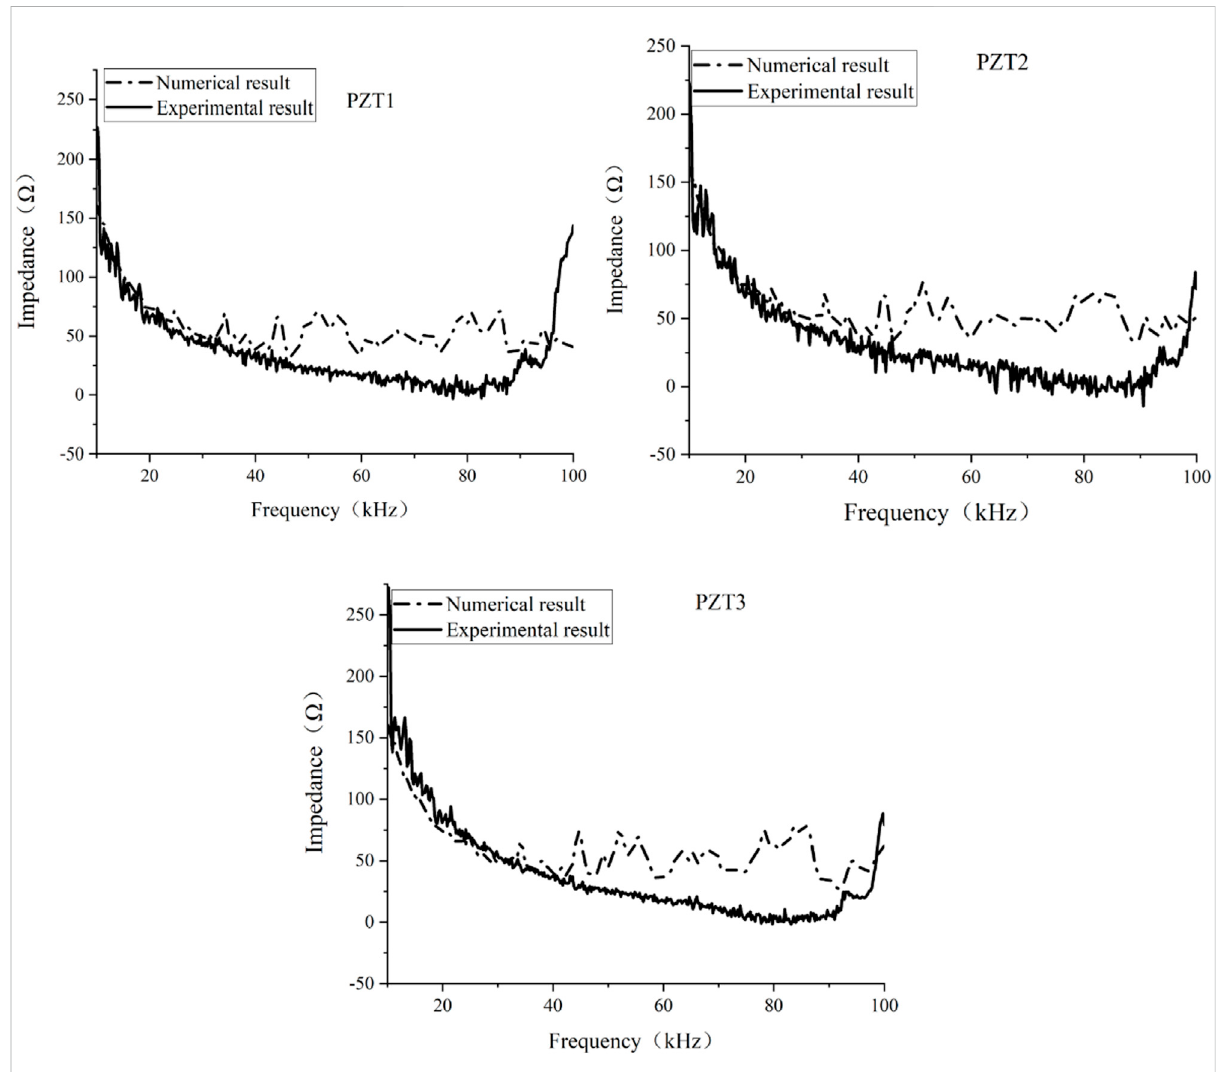
FIGURE 14 Impedance curve of the PZT sensors at the frequency range of 10 – 100 kHz.